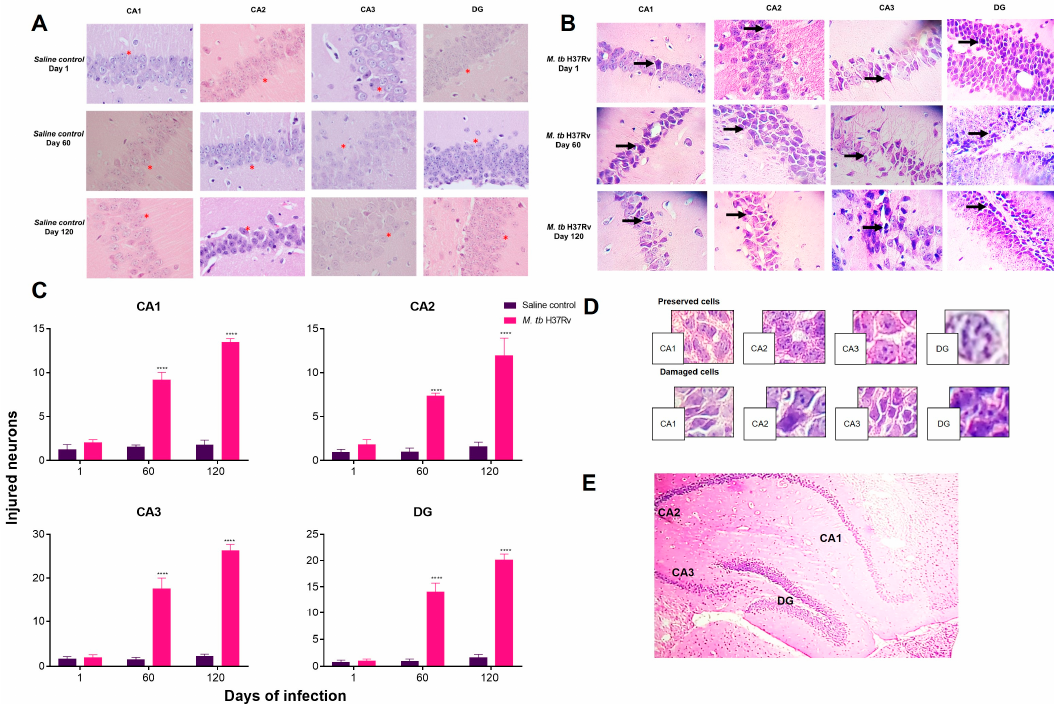
Figure 8. Pulmonary infection with M. tb induced neuronal death in the hippocampus in the late phase of infection. Representative image of the saline group ( A ) and tuberculous mice ( B ) with H&E staining (40 × ). The asterisks (*) in 8A show preserved hippocampal cells. Arrows indicate damaged cells. ( C ) The percentage of cells injured per field. ( D ) The criteria used to discriminate damaged cells from healthy cells. ( E ) A coronal section of the mice brain, indicating the hippocampus areas from where the fields were obtained for quantification. The infected mice presented a critical number of injured cells in the hippocampus, mostly in the CA3 region and in the DG in contrast to the saline group. Data are expressed as mean ± SEM. CA1 F (1, 10) = 218.6, p < 0.0001, two-way ANOVA; **** p <